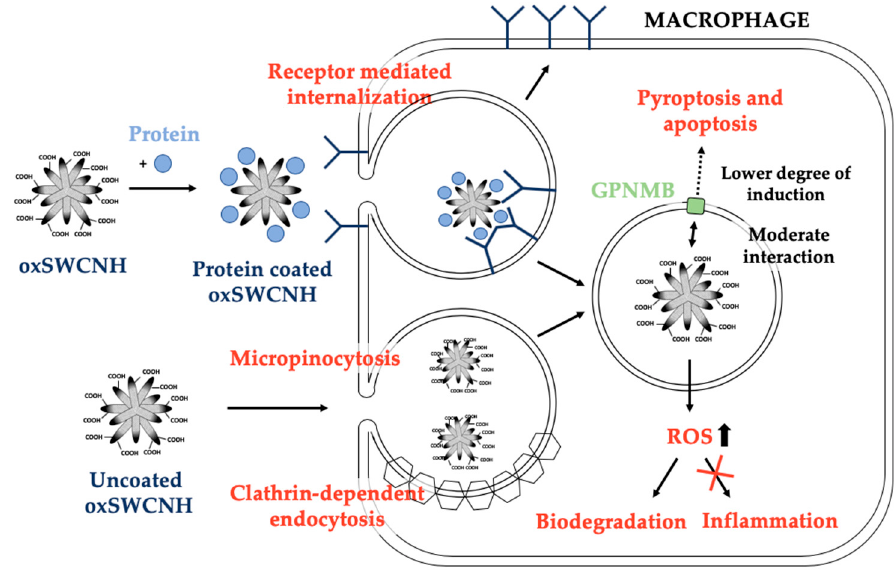
Figure 3. SWCNH uptake processes in macrophages. SWCNH are mainly engulfed by activated macrophages via direct trans-membrane uptake or receptor-mediated processes. Protein-coated SWCNHs follow a receptor-mediated internalization and SWCNHs without coating biomolecules can be internalized by micropinocytosis or clathrin-dependent endocytosis. Macrophages, after the uptake of SWCNHs, generate reactive oxygen species (ROS) to achieve the degradation of the nanomaterials without triggering any inflammatory pathway during this process. On the other hand, SWCNHs have a moderate interaction with glycoprotein nonmetastatic melanoma protein B (GPNMB) inducing a lower degree of cascade actions to trigger pyroptosis and apoptosis in macrophages.